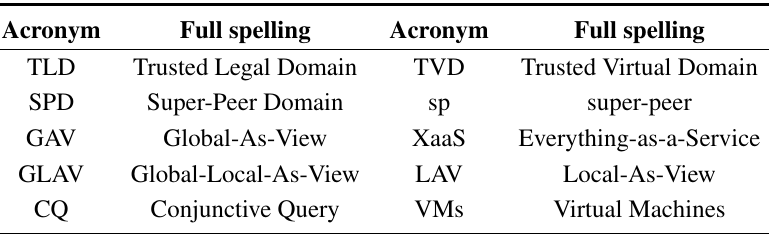
Table 1. An acronym table for frequently used